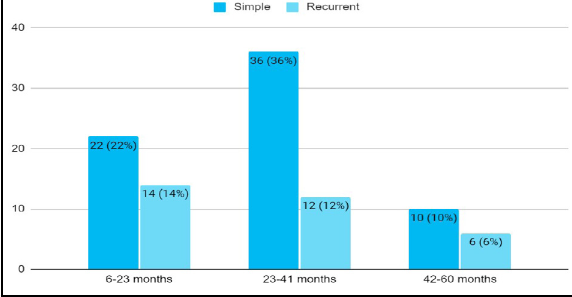
Figure 2. Distribution of febrile convulsion according to age group (n=